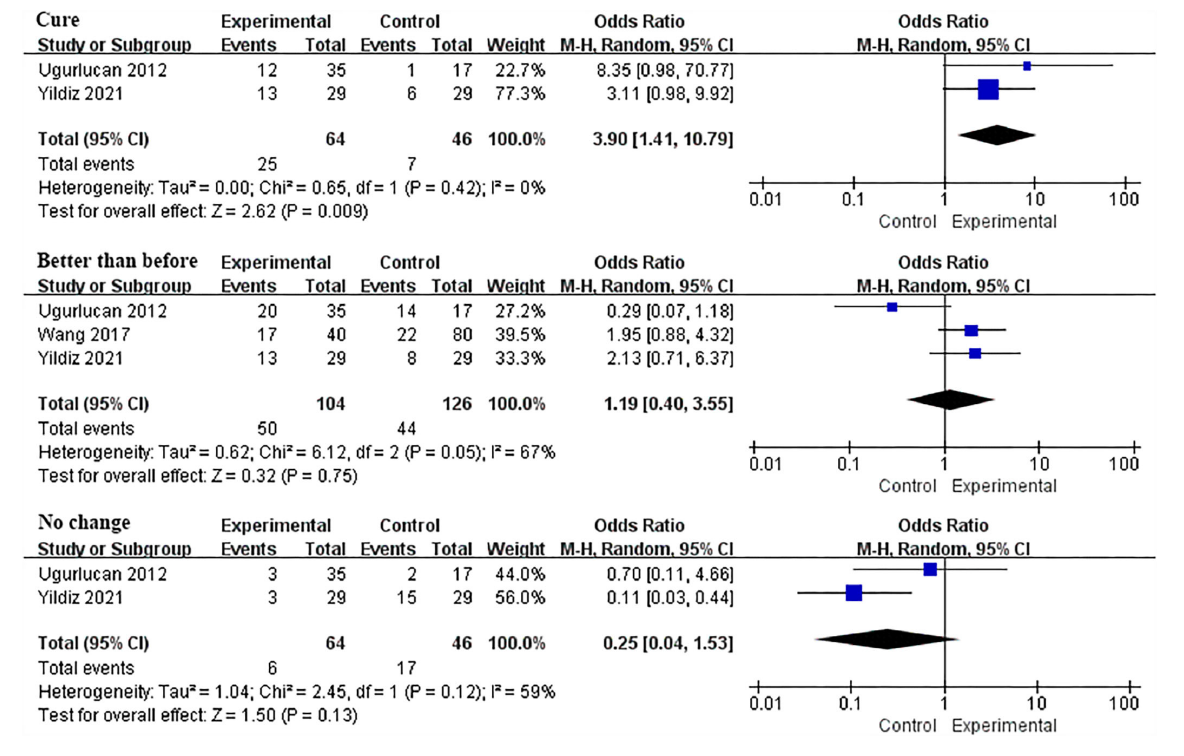
sham group: MD = − 0.04, 95% CI = [ − 4.34, 4.27],